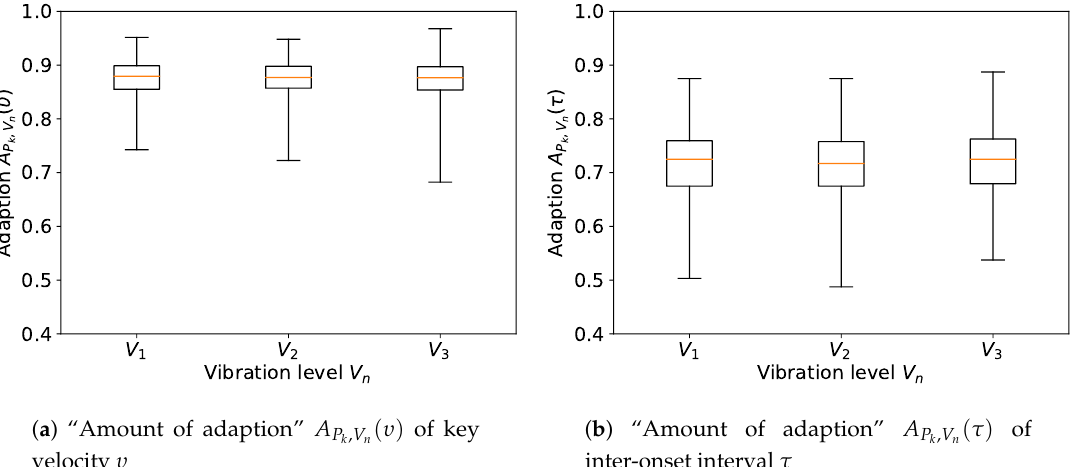
Figure 3. “Amount of adaption” to the feedback levels V n ( n = { 1,2,3 } ) relative to the no-vibration condition V 0 across all pianists P k and for both performance parameters. The differences in the amount of adaption for all vibration levels are not significant for both parameters. The line in the center of the box-plot marks the median, the box extends from the first to the third quartile, and the whiskers mark the value